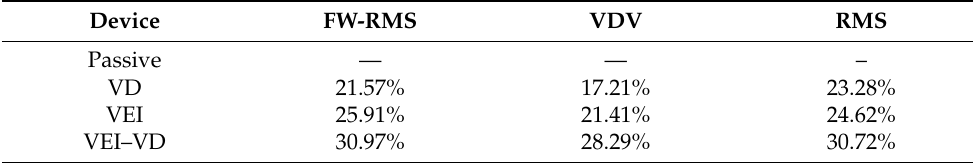
Table 3. Vibration reduction compared to passive.